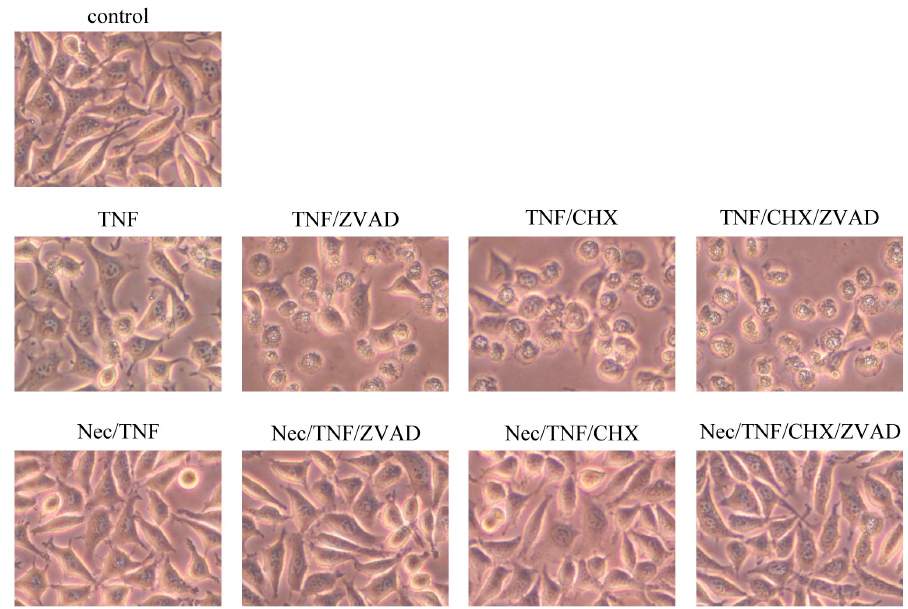
Figure 1. Induction of necroptosis in tumor necrosis factor (TNF)-treated L929 cells. L929 cells were treated with 10 ng/mL TNF, 10 µ M Z-VAD-fmk (ZVAD), 10 µ g/mL cycloheximide (CHX), or 10 µ M necrostatin-1 (Nec) for 3 h. Photos of phase-contrast microscopy (original magnification 400 × ) are